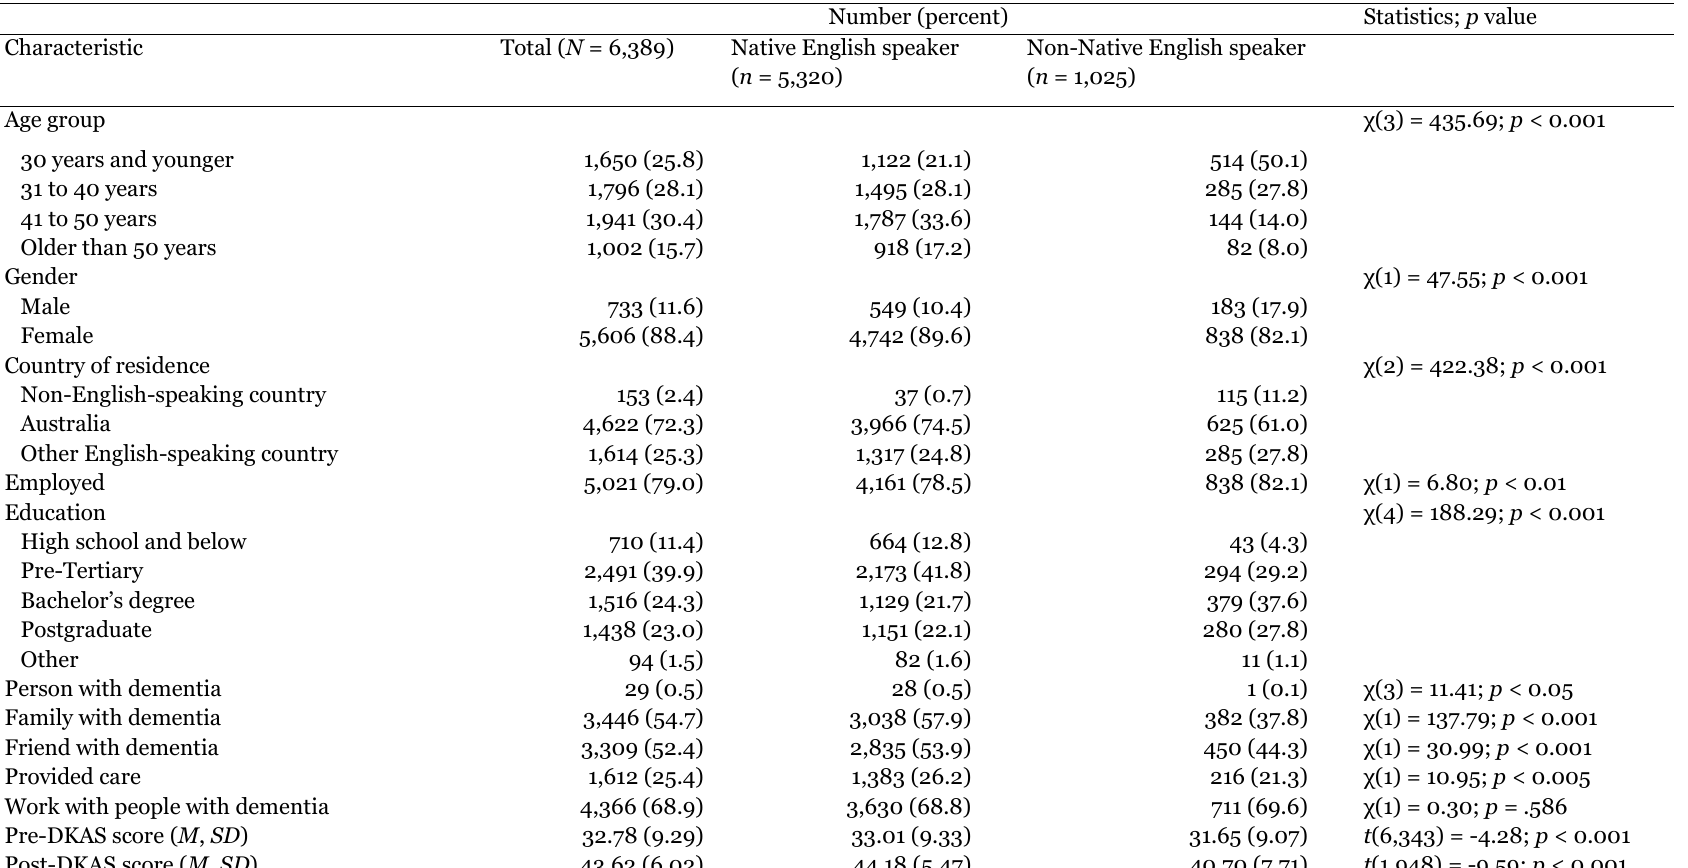
Sample Characteristics of the UDMOOC Enrolees: Comparing Native and Non-Native English